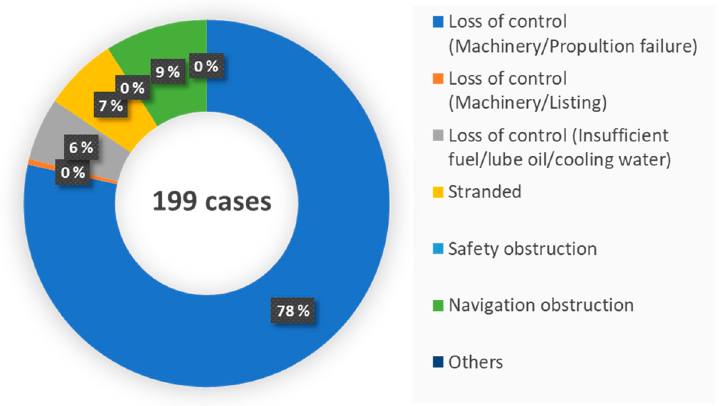
Figure 9. Number of marine incidents in 2019.